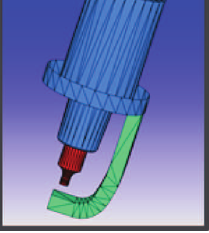
Fig. 7. Spark plug surface split into more than one surface, as required by the